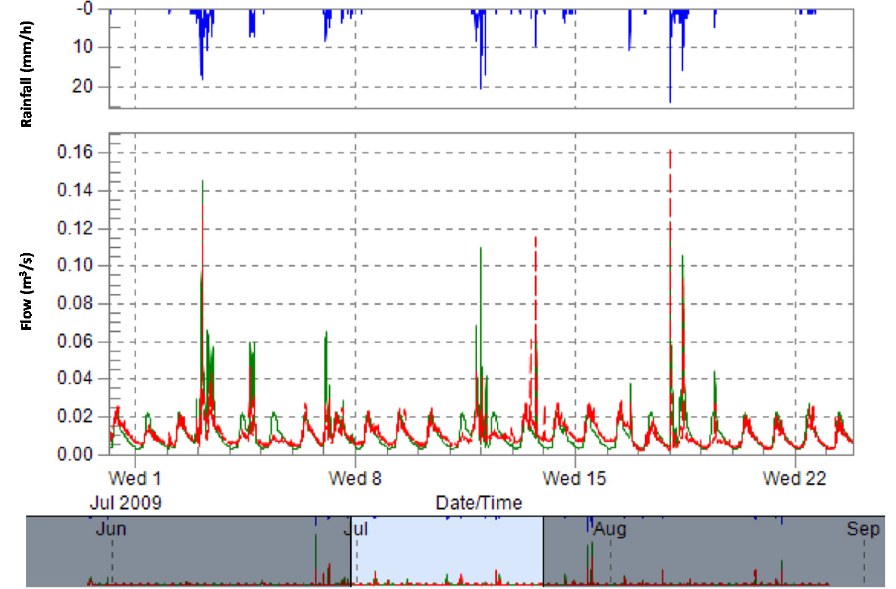
Figure 6. Example of validation results at the Giffard measuring point (red line = measured flow rate; green line = simulated flow rate) (taken from